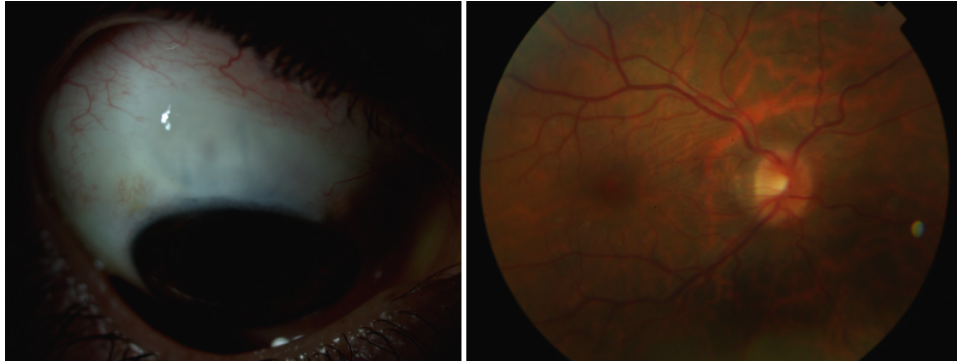
Figure 1: Thin filtration bleb and chorioretinal folds